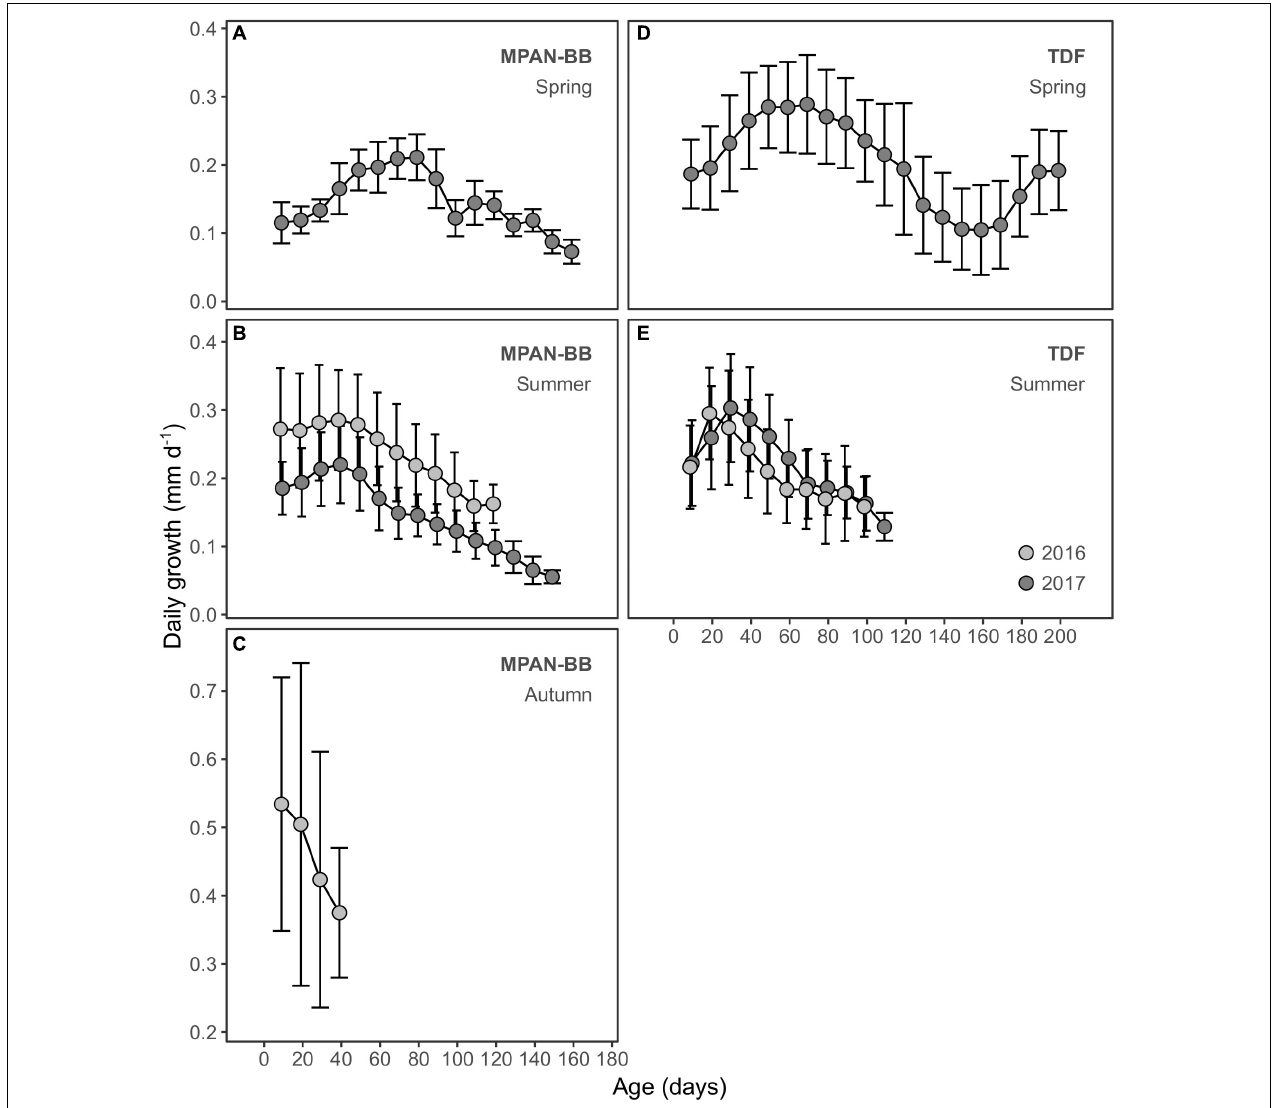
FIGURE 5 | Daily growth (mm d − 1 ) in relation to age (days) of Fuegian sprat Sprattus fuegensis in the Marine Protected Area Namuncurá-Burdwood Bank (MPAN-BB) (A–C) and Tierra del Fuego (TDF) (D–E) . Records are grouped according to the year sampled (colors) and season of hatching: spring (A,D) , summer (B,E) and autumn (C) . Daily growths are averaged every 10 days, with variation around the mean displayed as standard